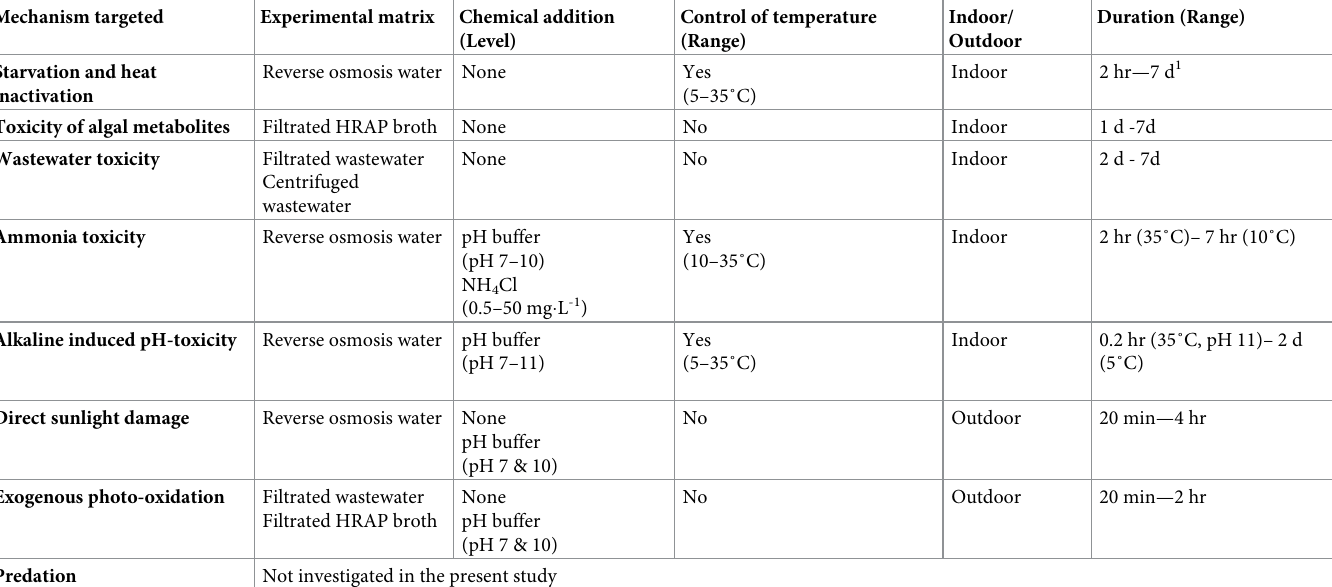
Table 1. Summary of the conditions tested during laboratory assays. Experimental matrix Chemical addition